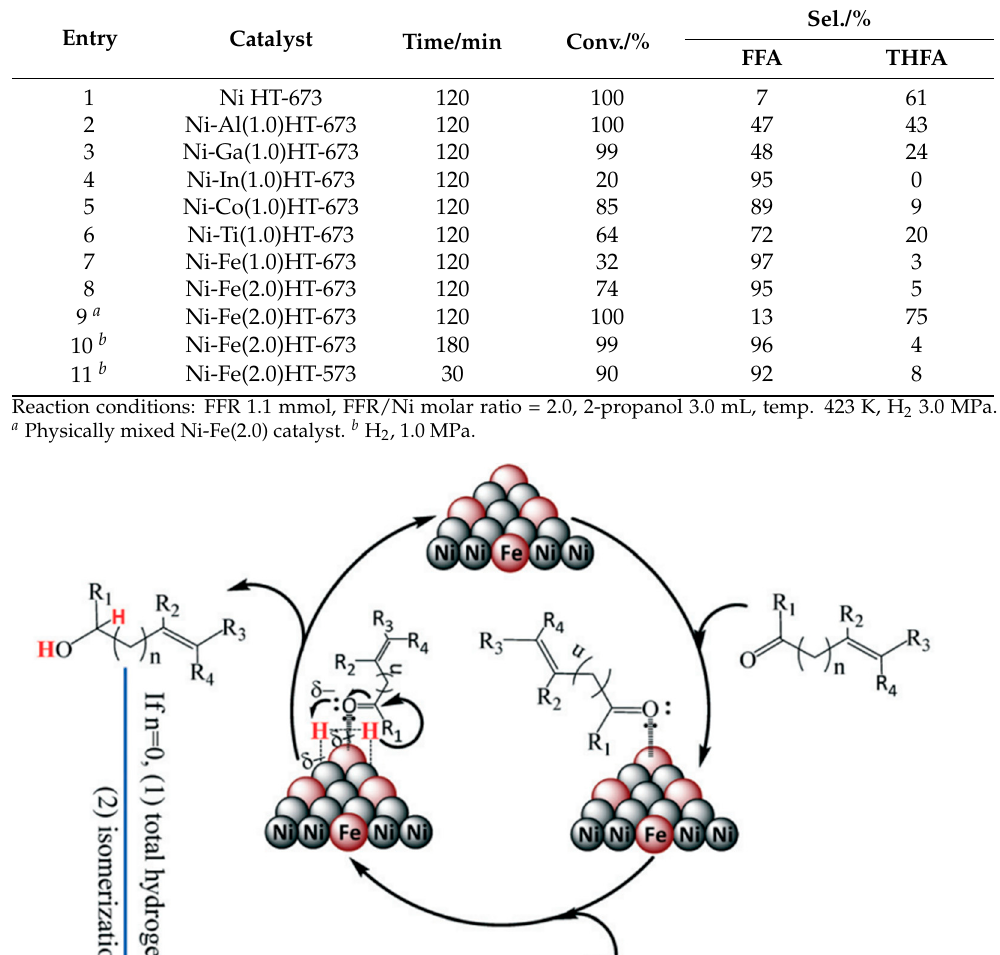
Table 2. Hydrogenation of FFR by various bulk (Ni-M) catalysts. Adapted from [65] with slight modification.